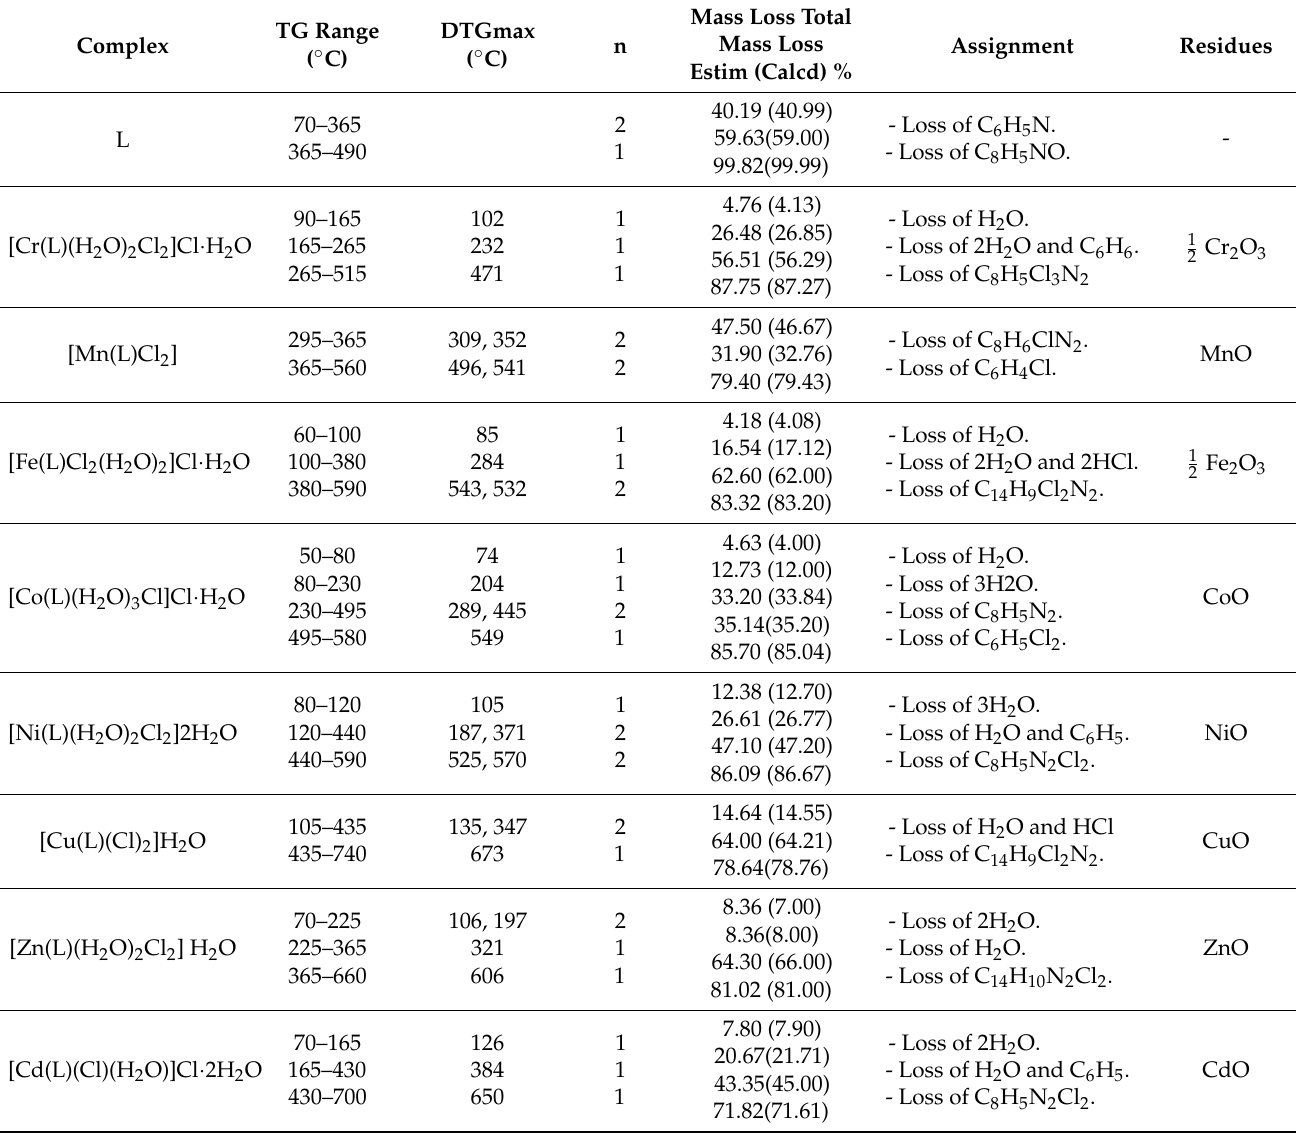
Table 2. Thermoanalytical data of the metal complexes of the Schiff base